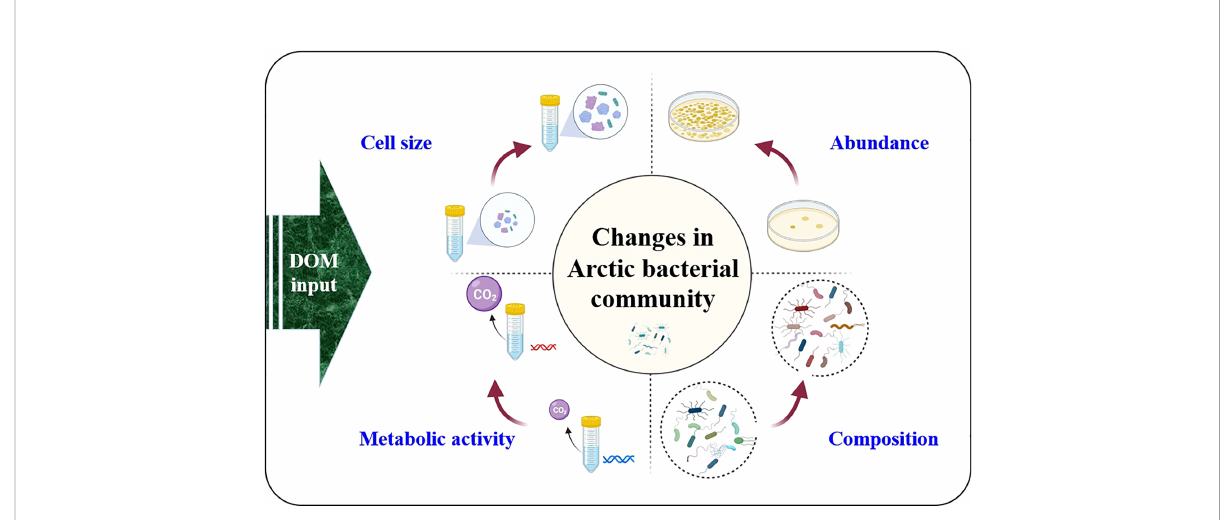
FIGURE 3 Elevation in population, size, metabolic activity, and structure of the bacterial communities in the Arctic Ocean as a result of the increased DOM in